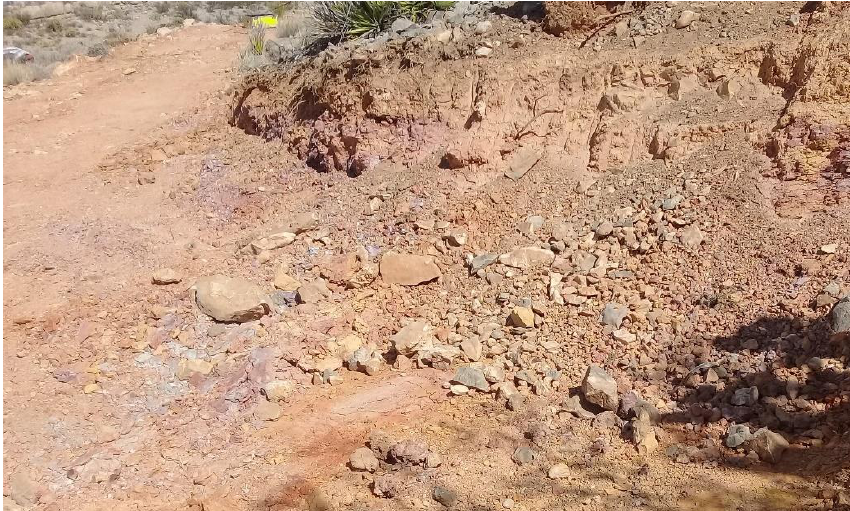
Figure 7. Iron oxide and clays zone in profile 3.